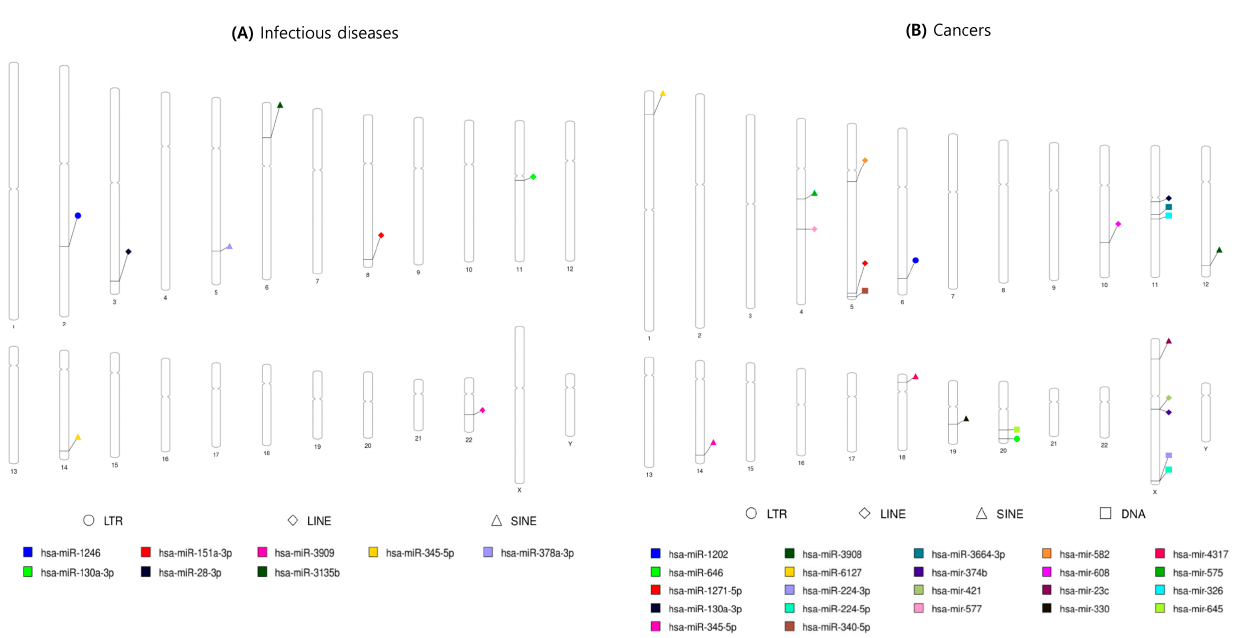
Figure 4. Chromosome ideogram shows the MDTEs in relation to ( A ) infectious diseases or ( B ) can- cers. Each diagram indicates the chromosomal location of these MDTEs.